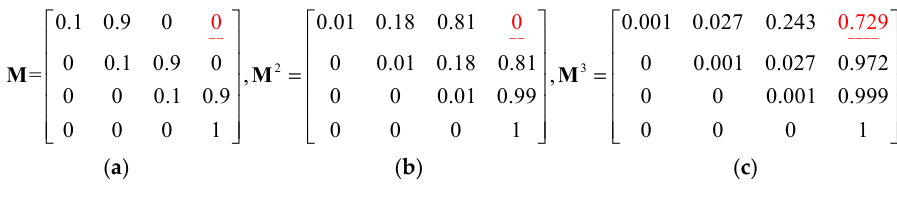
Figure 6. ( a ) M ( b ) M × M ( c ) M × M × M .